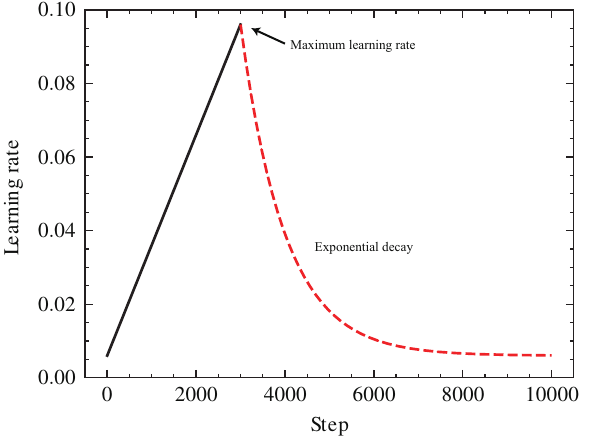
Figure 3. Learning rate exponential decay. Table 2. The main hyperparameter settings used in DDINN implementations and evaluation experiments.